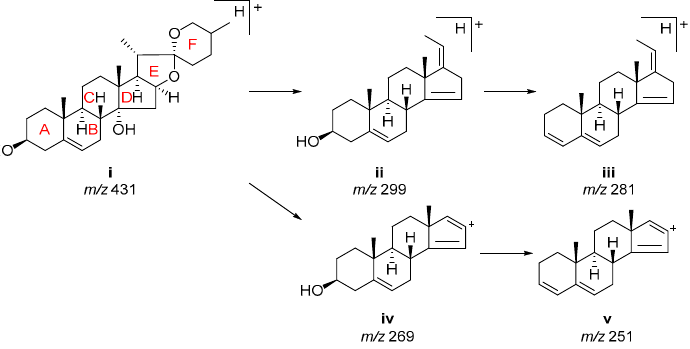
Figure 4. Proposed fragmentation pathway for the aglycone of compound 25 .